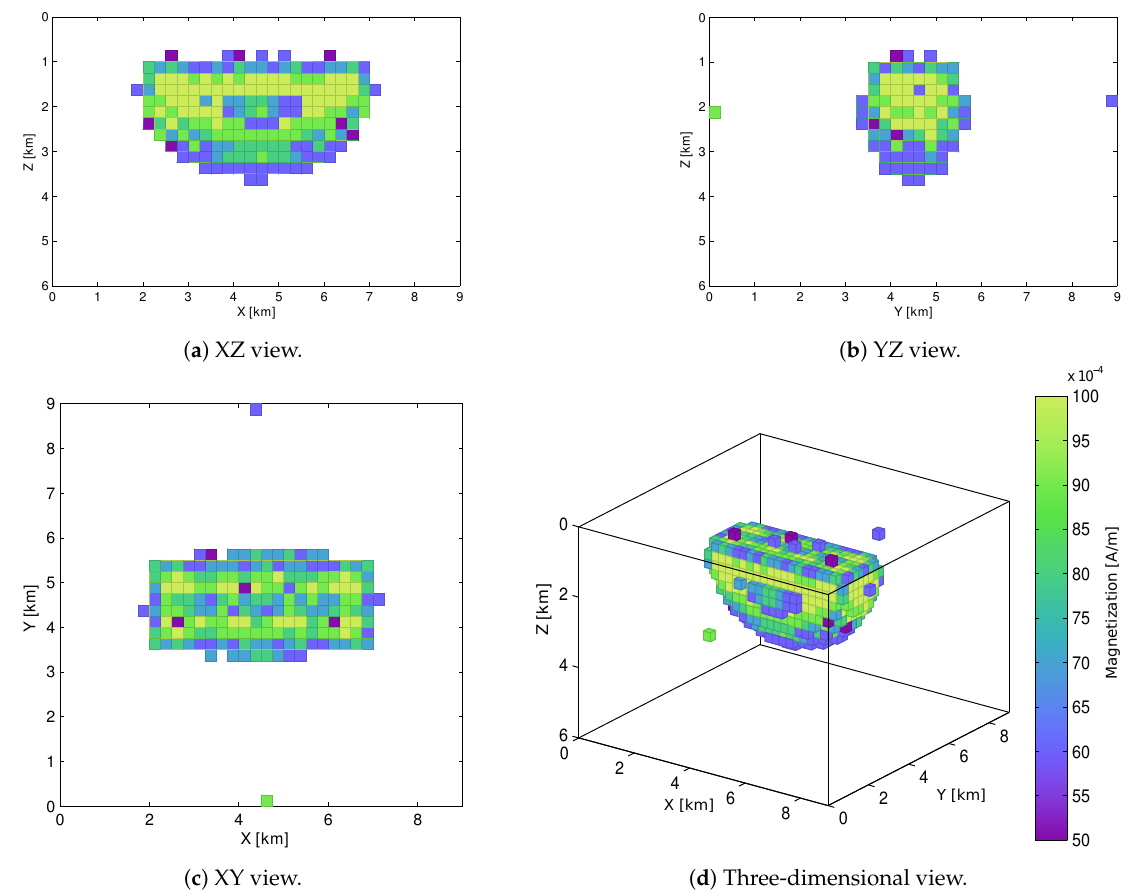
Figure 16. Inverted magnetic T